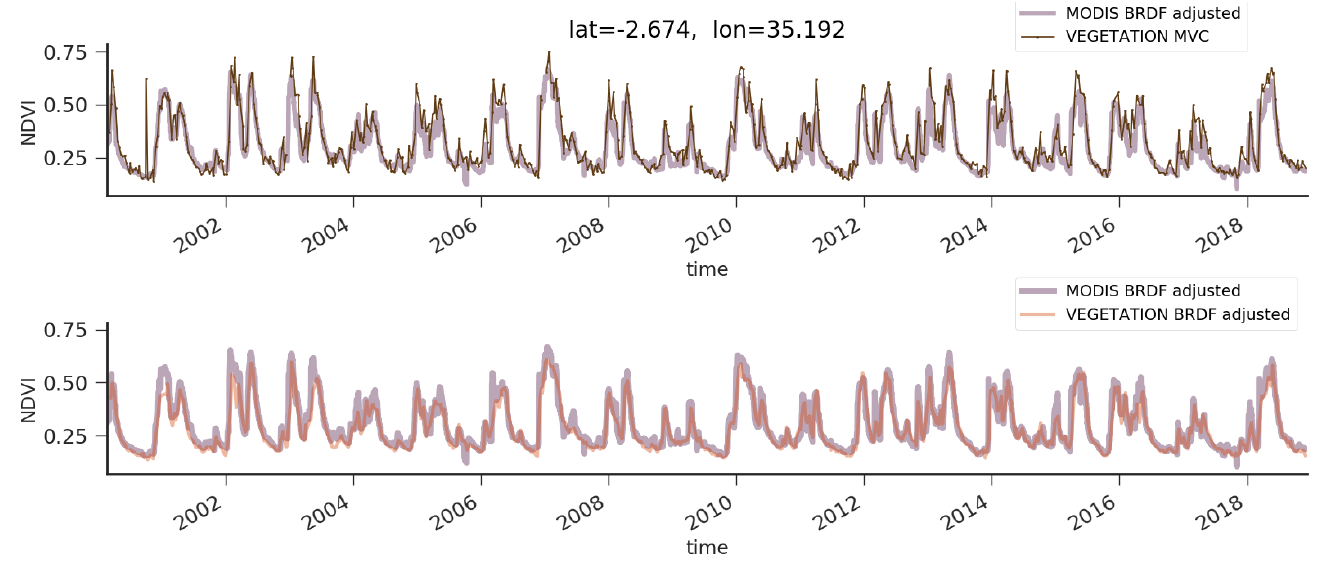
Figure 10. NDVI time-series derived from MODIS MCD43A4 nadir BRDF-adjusted reflectances for a pixel close to Belmanip 151 site. Overplotted in the top and bottom panels are the MVC and BRDF-adjusted NDVI time-series. NDVI Time-Series are color and line encoded as shown in the